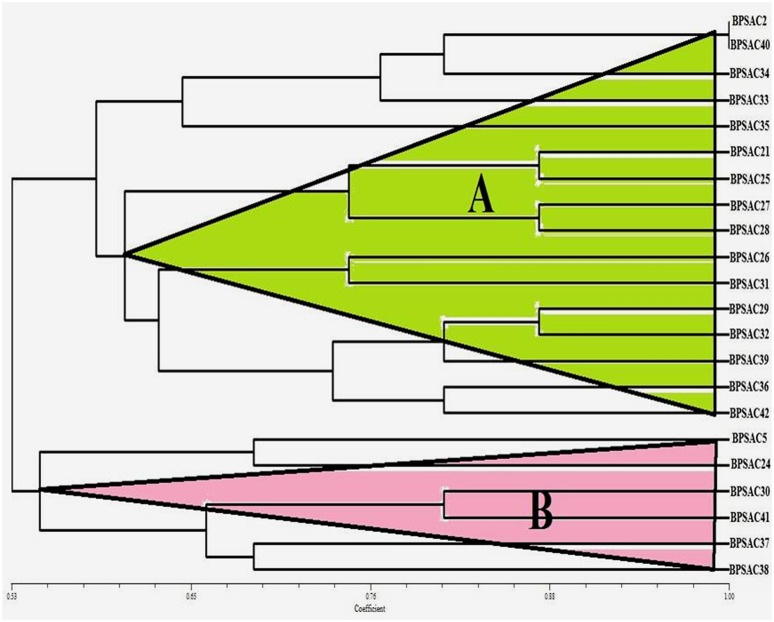
Dendrogram generated from BOX PCR genomic fingerprints of endophytic actinomycetes isolates using Ntsys 2.0.